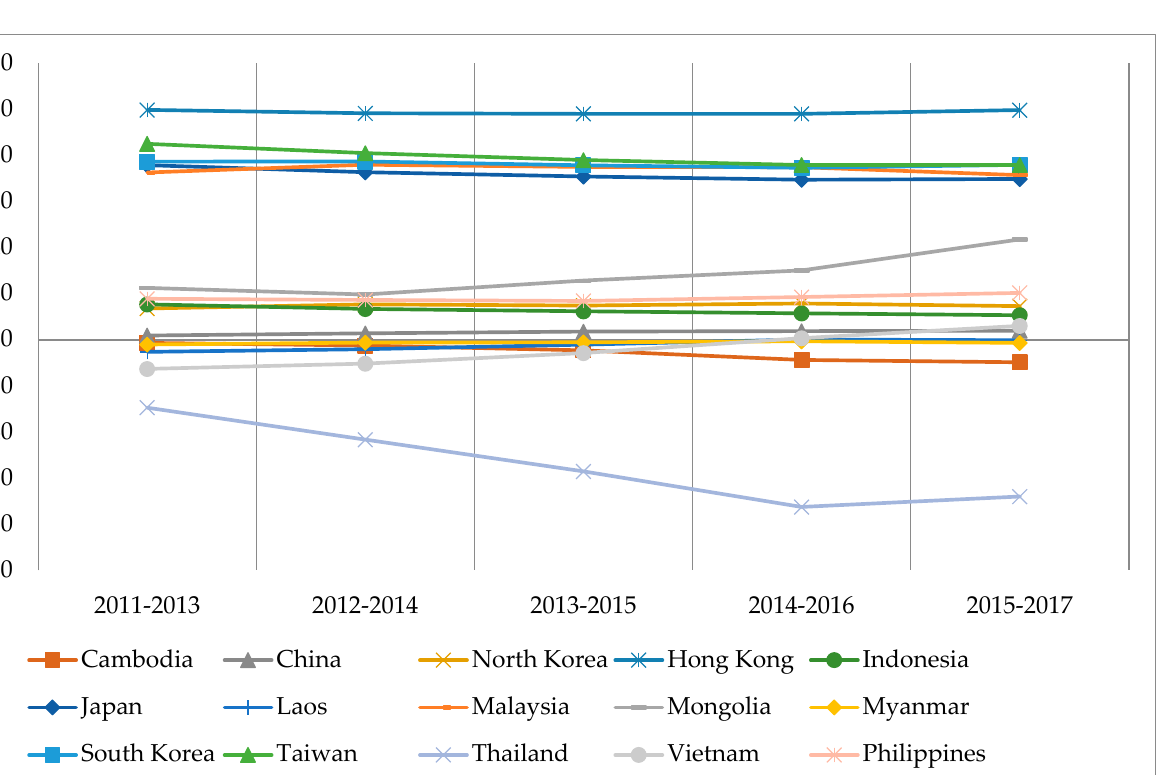
Figure 4. Percentage point change in cereal import dependency ratio in East and Southeast Asia (Source: data retrieved and adapted from [4]).